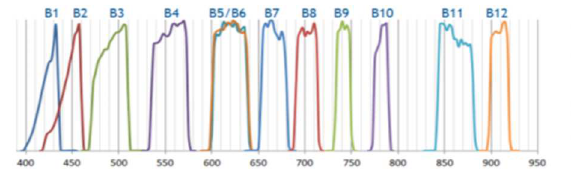
Figure 3. Venµs Spectral Bands. Notice that B5 and B6 share the same spectral band.